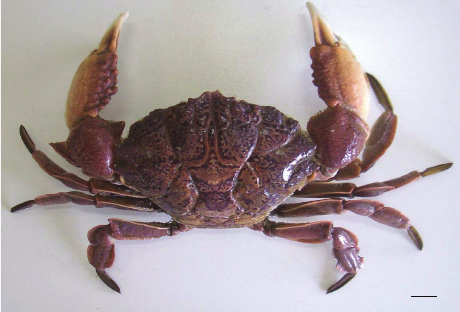
Figure 2: D. cultripes collected from Camotes Sea near Cebu Island. (Scale bar = 1.0cm).